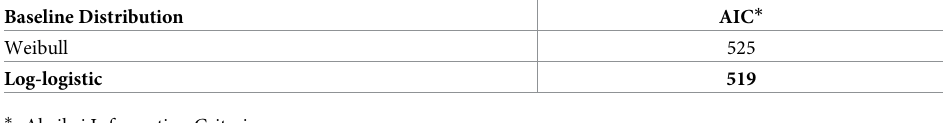
Table 5. Comparison of AFT models using AIC criteria for leprosy patients at ALERT (LPAC, From 2015–2019).